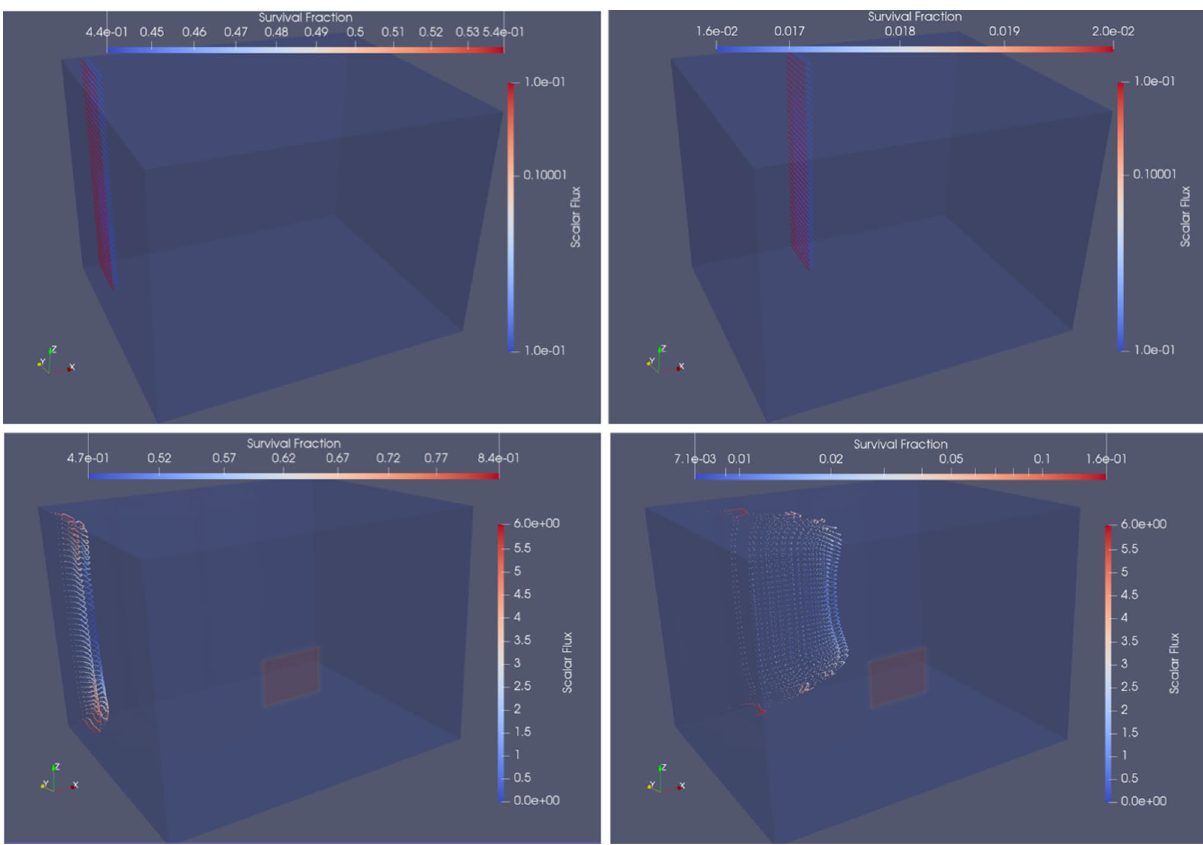
Figure 3. Aerosol distribution within the irradiation chamber and human coronavirus survival fraction at 2 (left) and 10 (right) seconds. Top: predictions when uniform flow and far-UVC intensity are assumed, Bottom: predictions using CFD-flow and model-predicted far-UVC radiation fields. Particle colour denotes survival. Assumed far-UVC intensities are superimposed.